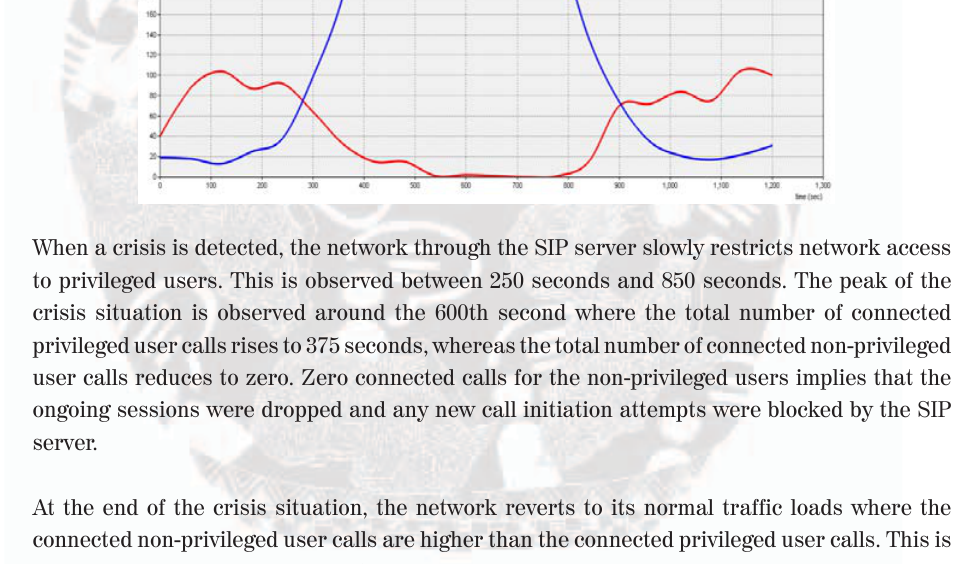
FIGURE 12: CALLS CONNECTED BY THE SIP